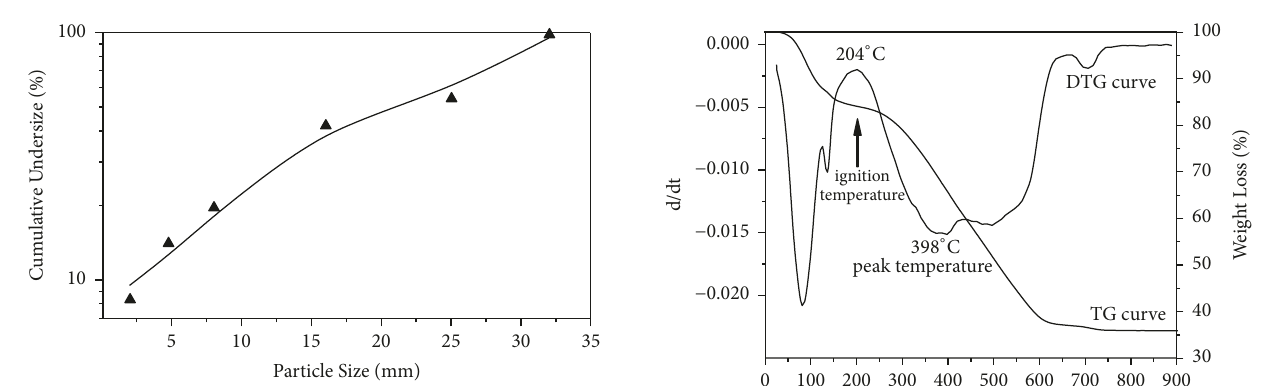
Figure 1: Particle size distribution of coal sample.